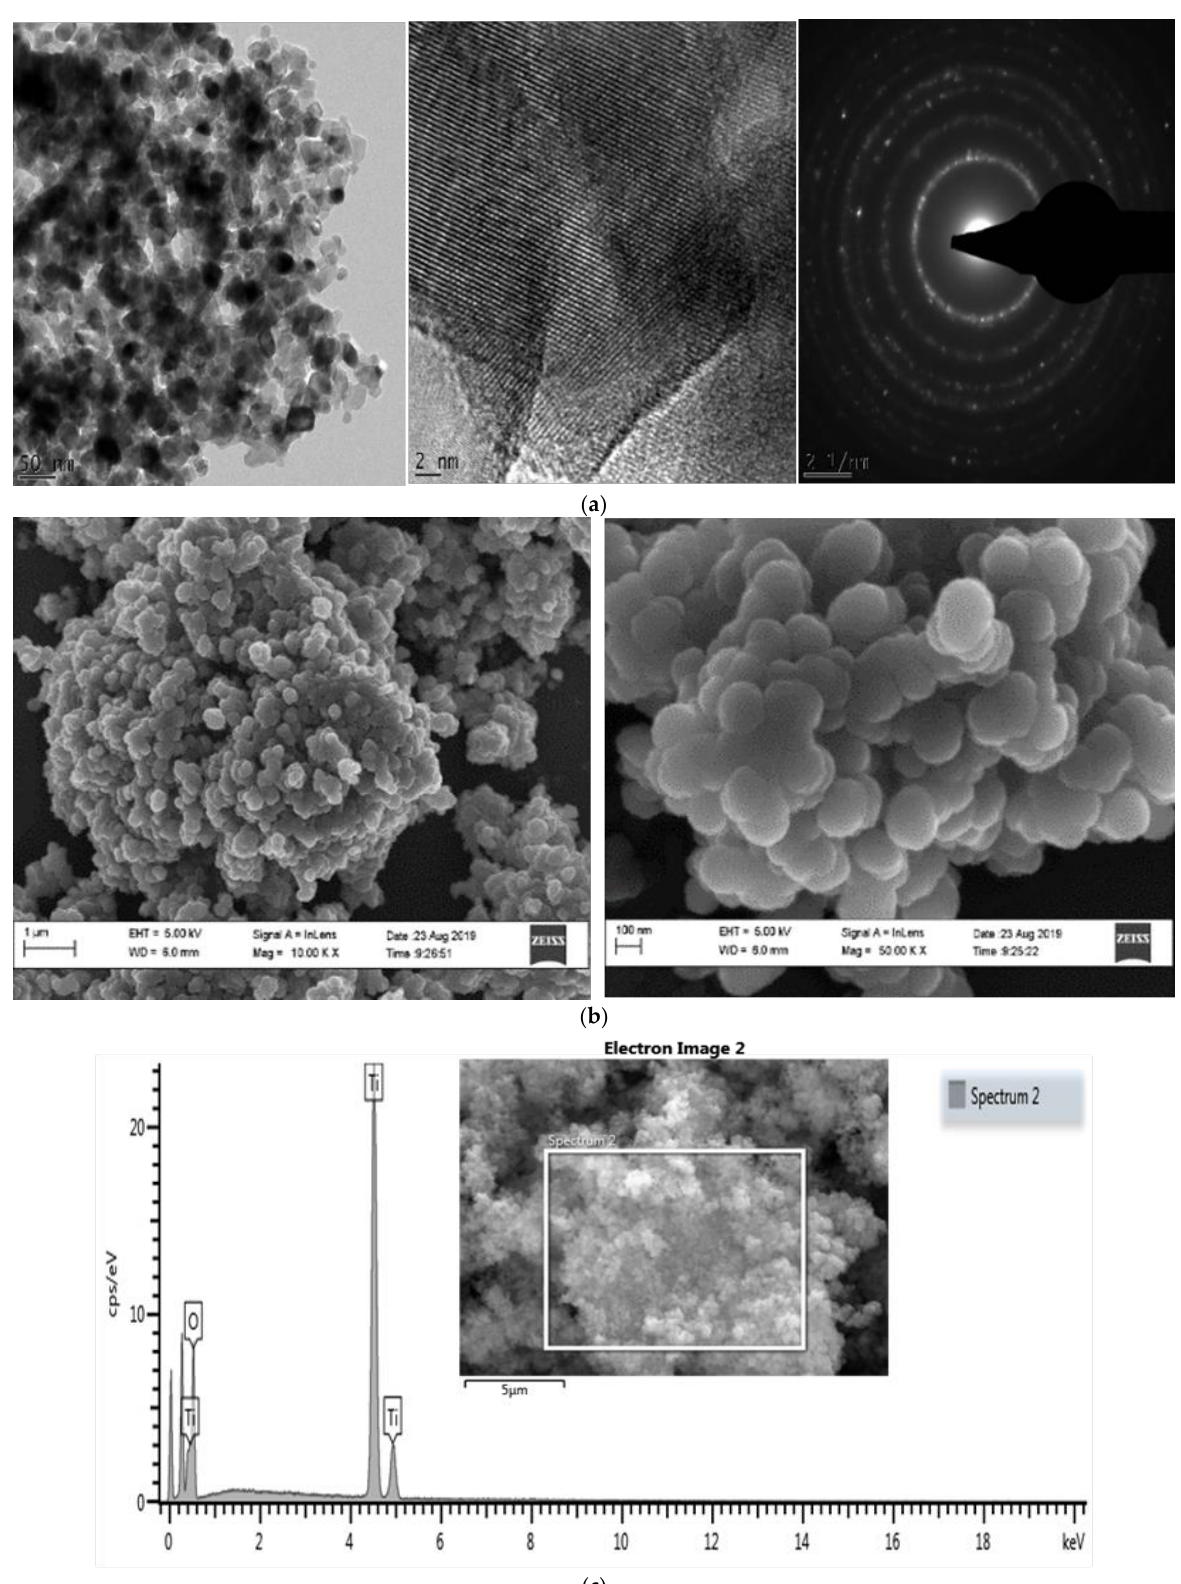
Figure 1. Characterization of TiO 2 NPs; ( a ) TEM analysis of TiO 2 NPs. ( b ) SEM analysis of TiO 2 NPs. ( c ) SEM Energy Dispersive X-ray analysis showing elemental TiO 2 and electron image analysis of TiO 2